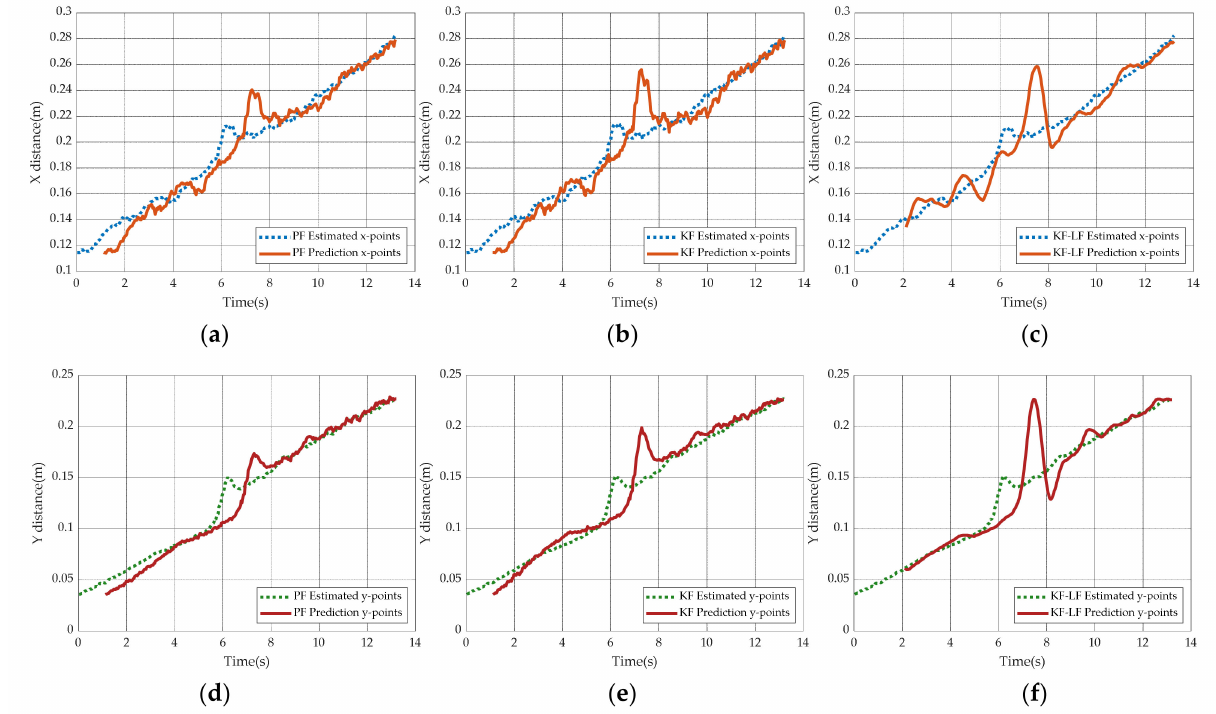
Figure 13. Comparison of the prediction effect of different filters under nonlinear conditions on the x-axis and y-axis: ( a ) is the effect of PF on the x-axis; ( b ) is the effect of KF on the x-axis; ( c ) is the effect of KF-LF on the x-axis; ( d ) is the effect of PF on the y-axis; ( e ) is the effect of KF on the y-axis; ( f ) is the effect of KF-LF on the y-axis.